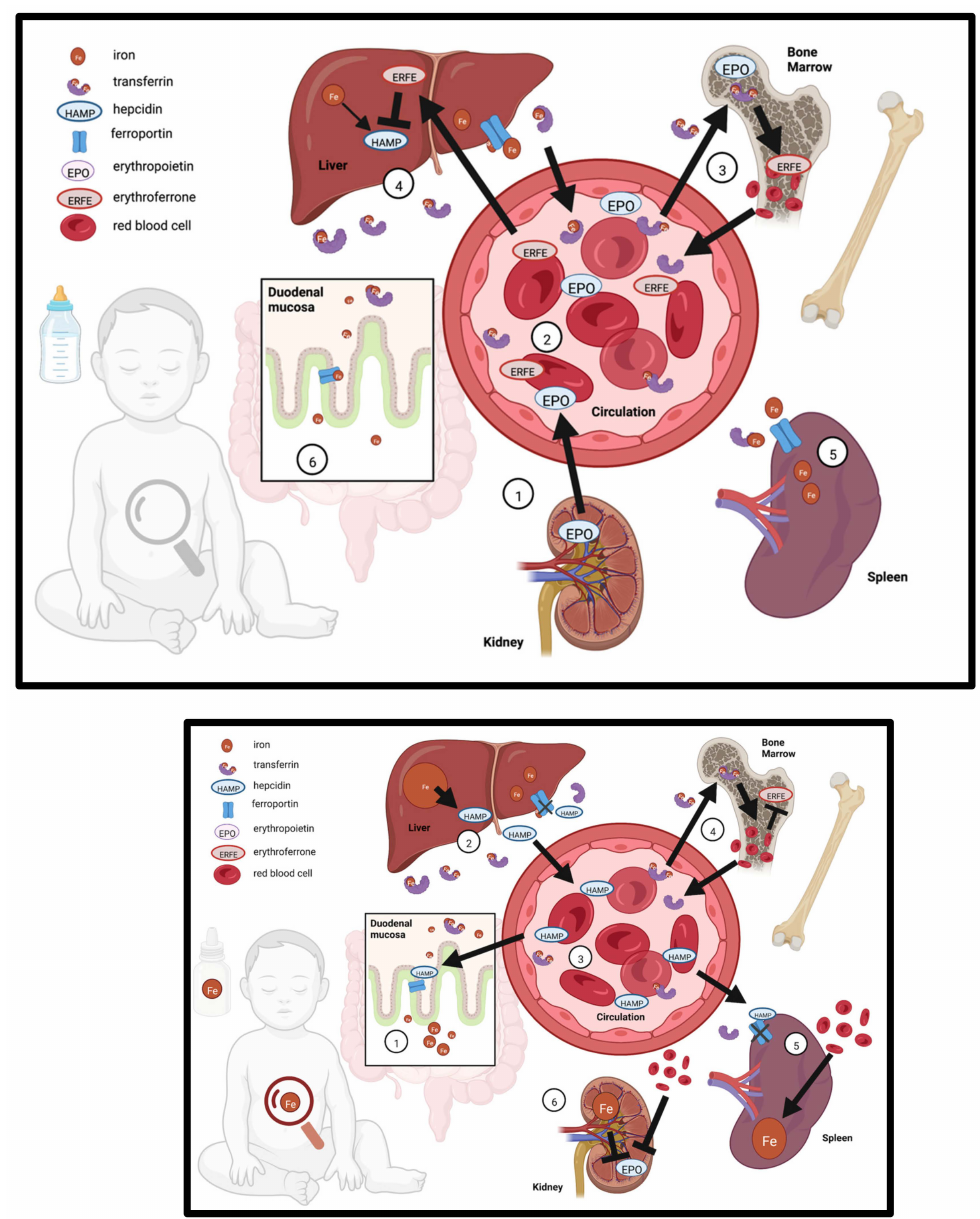
Figure 1. Iron regulation in the infant in response to iron supplementation. TOP—Iron regulation in the breast-fed infant in the absence of iron supplementation ( 1 ) The kidney secretes erythropoietin (EPO) to support the expansion of blood volume in response to low iron and low oxygen sensing; ( 2 ) EPO enters circulation and travels to the bone marrow, ( 3 ) where it drives erythropoiesis and secretion of erythroferrone (ERFE); ( 4 ) ERFE travels to the liver and suppresses hepcidin (HAMP) production, which allows for increased transferrin-bound iron in circulation; suppression of HAMP allows export of iron from the ( 5 ) spleen via ferroportin, as well as increased intestinal absorption of iron through ferroportin, both of which further increases iron in circulation. BOTTOM—Iron regulation in response to iron supplementation: ( 1 ) iron from supplementation is absorbed through the duodenal mucosa, is picked up by transferrin, and travels to the liver ( 2 ), increasing iron stores and up-regulating HAMP; ( 3 ) HAMP enters the circulation; ( 4 ) transferrin-bound iron supports increased erythropoiesis; in the spleen ( 5 ) erythrocytes are recycled but iron is sequestered because HAMP prevents export through ferroportin; ( 6 ) elevated iron and blood volume suppresses EPO production in the